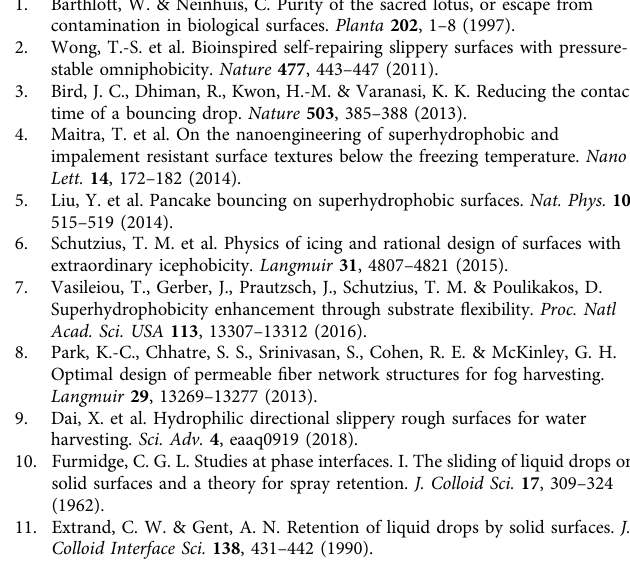
Figure source data are provided for the following fi gures: Figs. 1d – f, 2c – f, 3c, f – i, 4, 5b – d, 6c – f, Supplementary Figs. 1, 4 – 8, 10, and 11c, Any additional dataset generated and/or analyzed during the current study are available from the corresponding author on reasonable